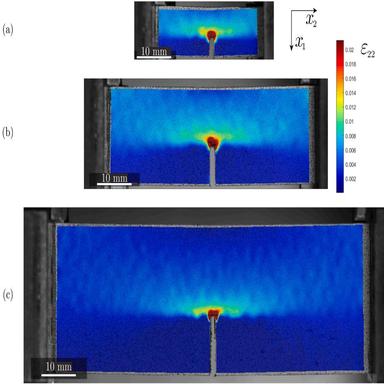
Strain in the loading direction, ε22, for three sizes of SENT specimens just before peak load instability: (a) 10 mm; (b) 20 mm; and (c) 30 mm characteristic size.